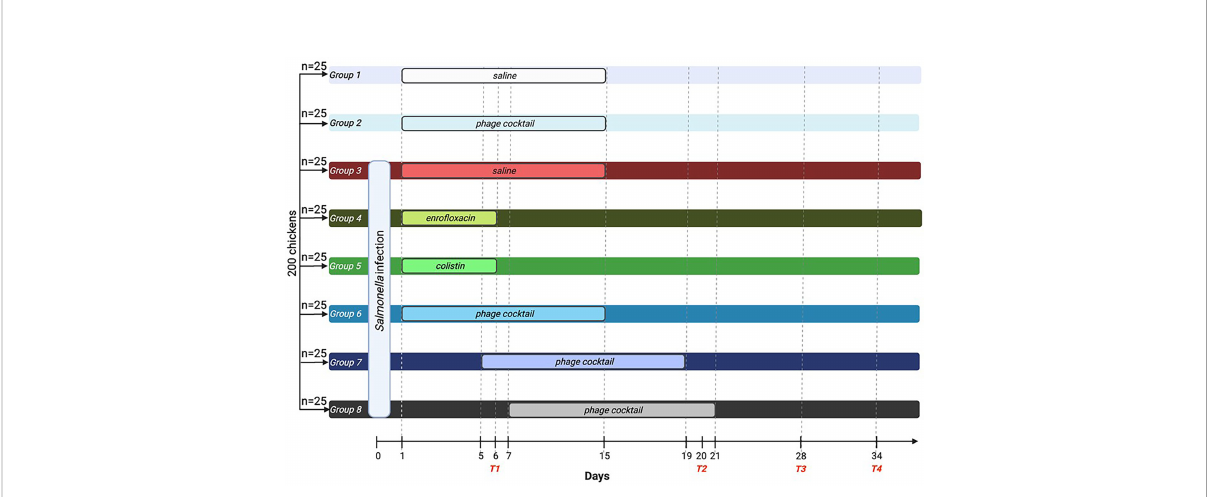
FIGURE 1 Diagram of the conducted experiment. A total of 200 birds were randomly divided into eight groups with 25 chickens each. On day 0 of the experiment, groups 3 – 8 were infected with Salmonella Typhimurium. Groups 1 and 2 were not infected with the bacteria. Groups 4 (enro fl oxacin) and 5 (colistin) were treated with antibiotics for 5 days. Groups 6 – 8 were treated with phage cocktail for 14 days. However, group 6 received the cocktail 1 day after infection, while group 7 received the cocktail 2 days after Salmonella detection in the feces, and group 8 received the cocktail 4 days after bacteria detection in the feces. On days 6, 20, 28, and 34, blood was drawn, and the animals were sacri fi ced. T1, termination 1; T2, termination 2; T3, termination 3; T4, termination